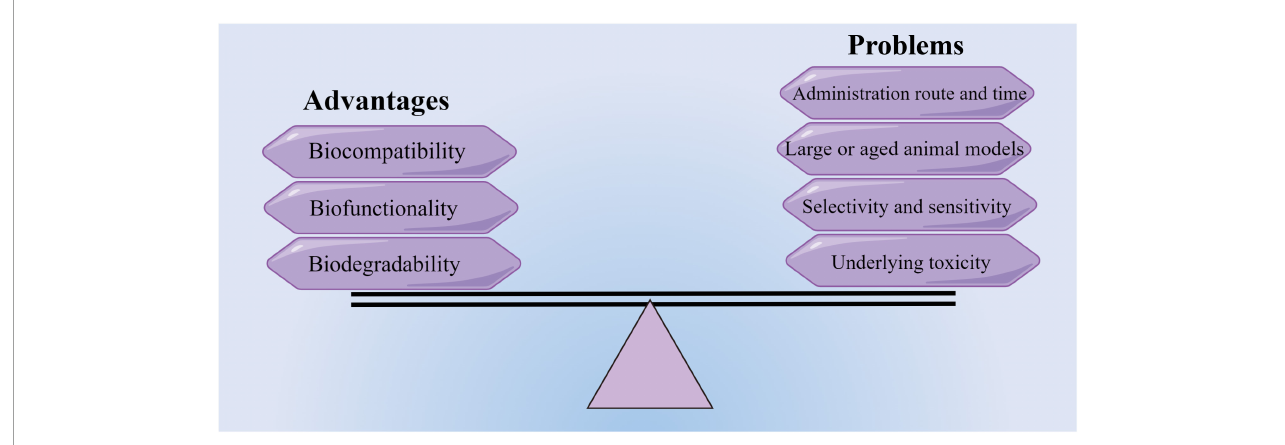
FIGURE3 Advantages and potential problems of translating new biomaterials into a potential treatment therapy (by figdraw).